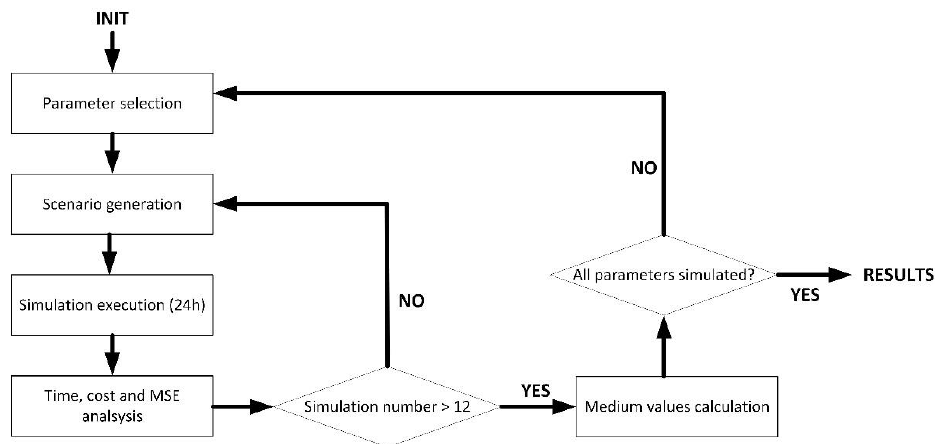
Figure 2. Experimental simulation setup.